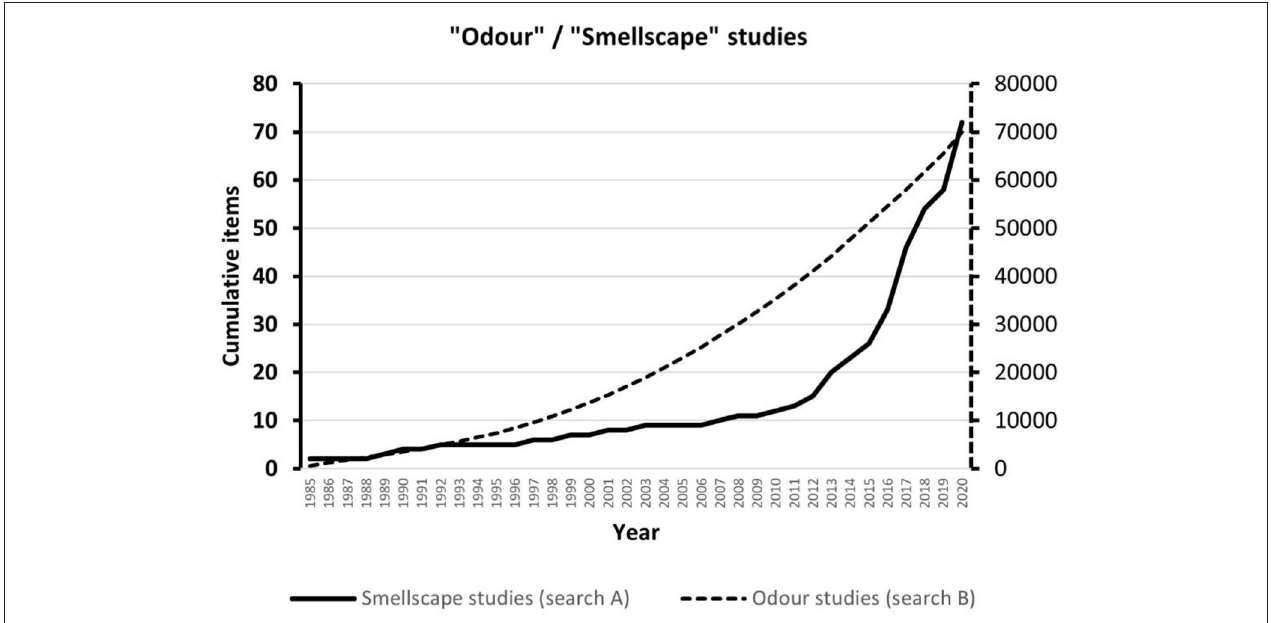
FIGURE 1 | Cumulative number of scientific publications on smellscape and the built environment (search A) and odour research in general (search B). Query string in Scopus for search A: TITLE-ABS-KEY (smellscap*) OR TITLE-ABS-KEY (smell) AND TITLE-ABS-KEY (“built environment”). Query string in Scopus for search B: